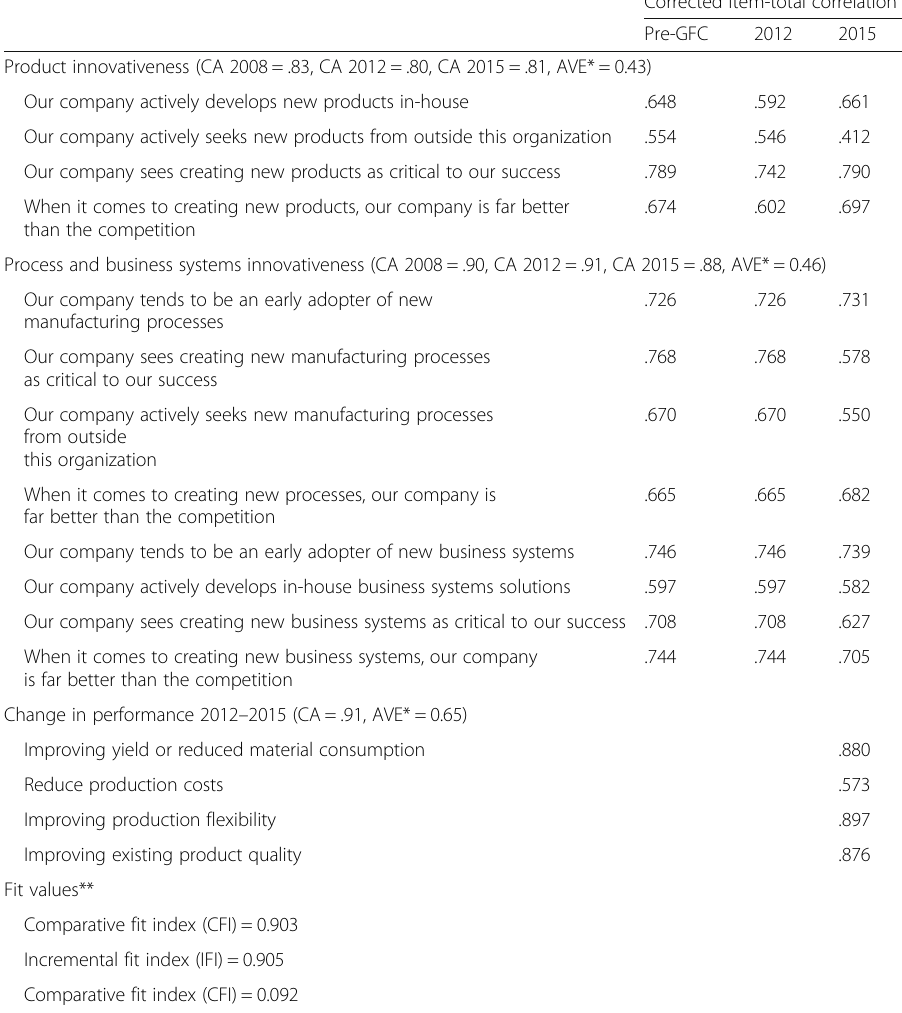
Table 7 Measurement items, confirmatory factor analyses, and reliability analysis